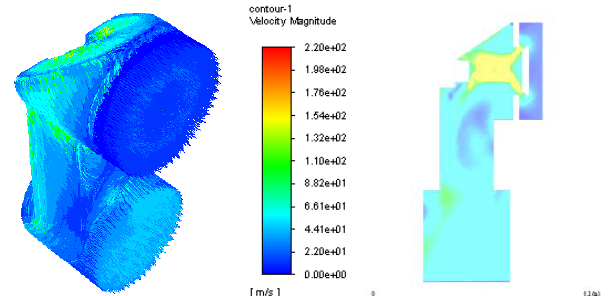
Fig. 13. The total temperature of charge in the new EGR valve